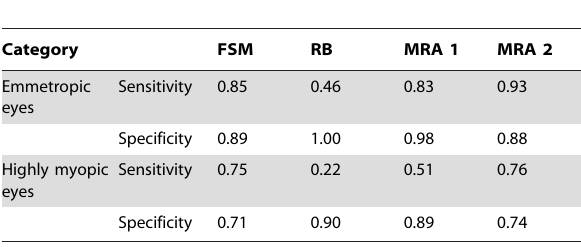
Table 3. Sensitivity and Specificity of FSM or RB Discriminant Function and Moorfields Regression